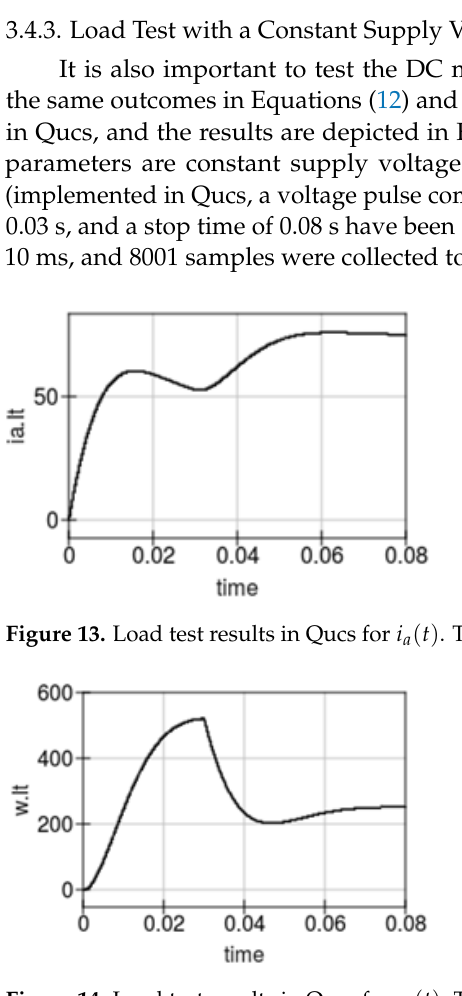
Figure 14. Load test results in Qucs for ω ( t ) . The load torque = 5